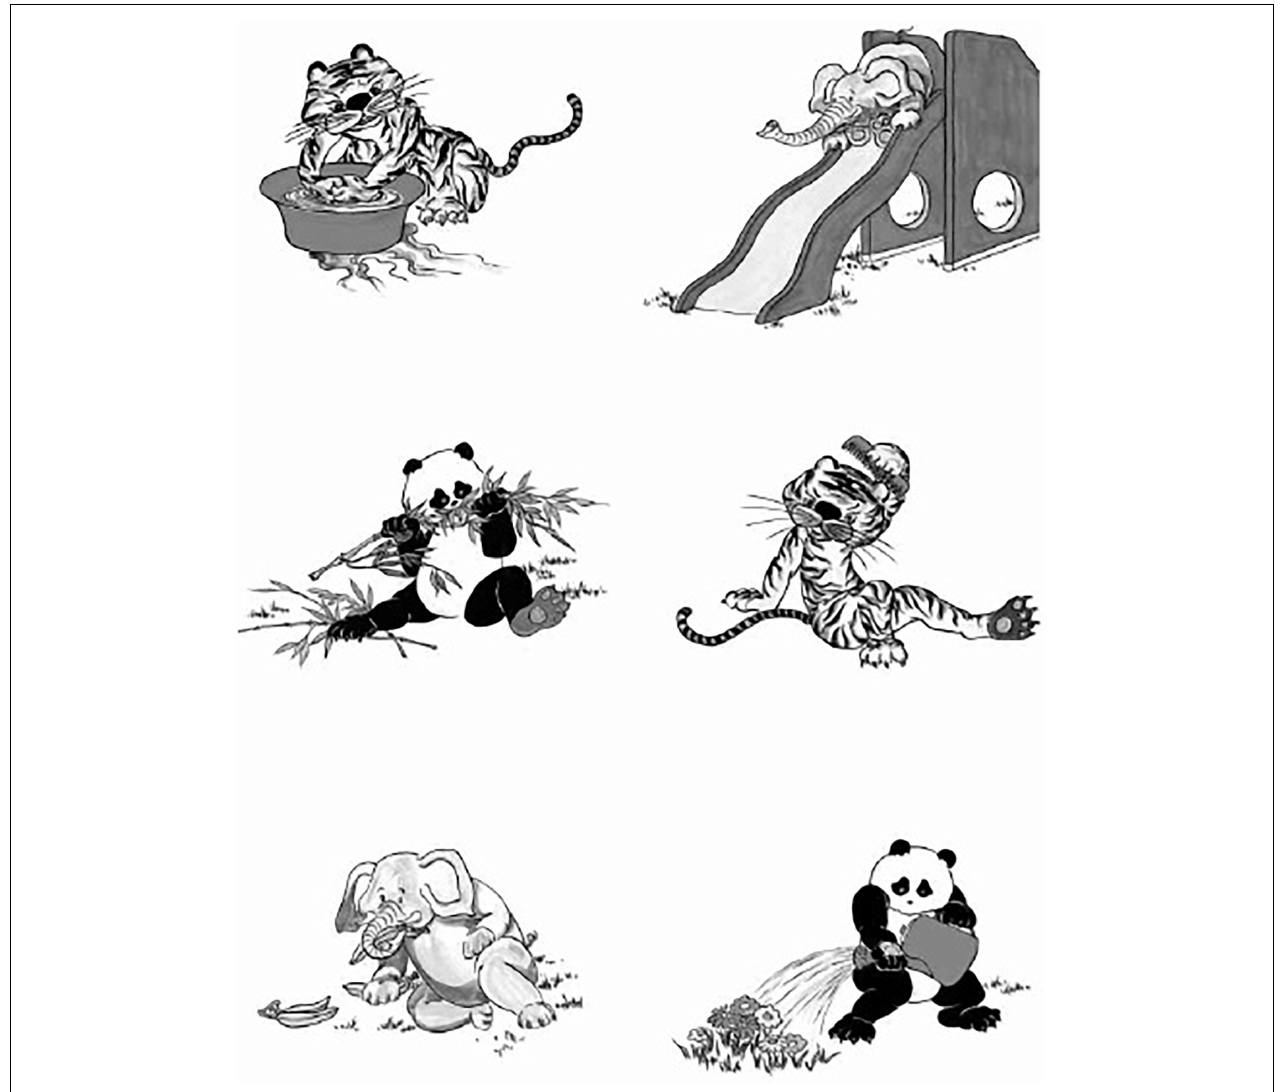
FIGURE 2 | A picture plate for the MPSI test from Zheng et al.